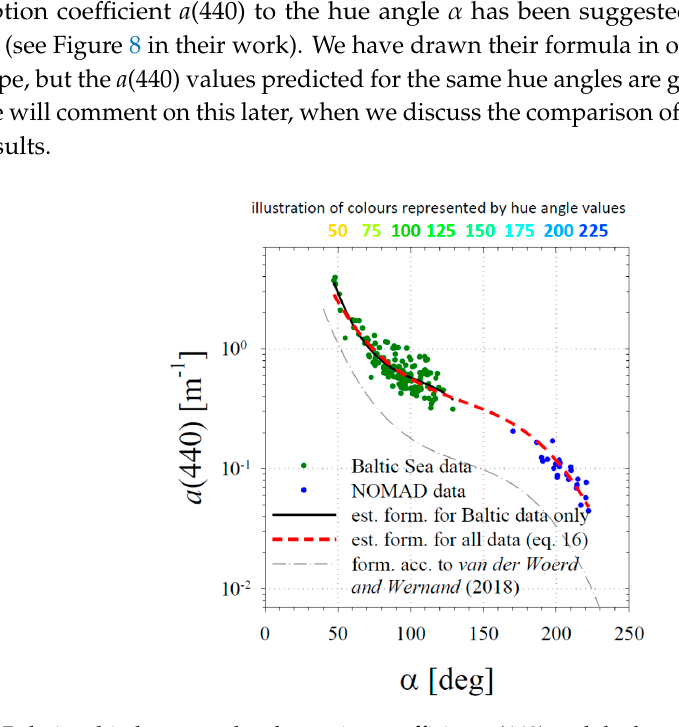
Figure 8. Relationship between the absorption coefficient a (440) and the hue angle α . Data from the Baltic Sea and the NOMAD database are shown as green and blue points. The two thick lines show the best polynomial relationships; the thin line represents the relationship according to van der Woerd and Wernand [22]. The additional legend above the horizontal axis illustrates the colours represented by selected values of the hue angle α .